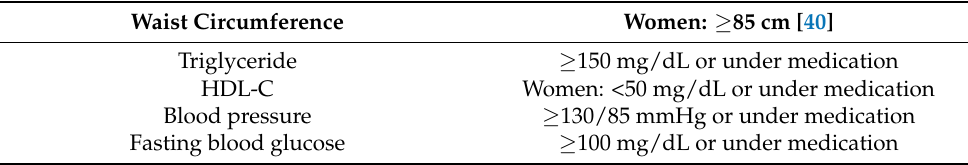
Table 1. Five diagnostic criteria for metabolic syndrome (MS) [39]. Waist Circumference Women: ≥ 85 cm [40] Triglyceride ≥ 150 mg/dL or under medication HDL-C Women: <50 mg/dL or under medication Blood pressure ≥ 130/85 mmHg or under medication Fasting blood glucose ≥ 100 mg/dL or under medication HDL-C: high-density lipoprotein